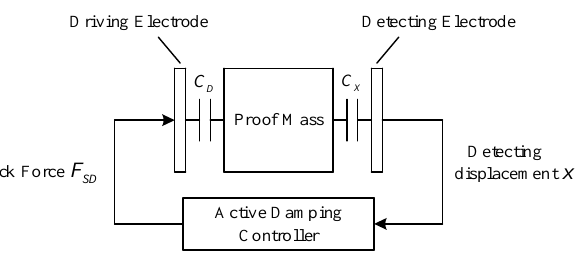
Figure 2. Block diagram of the principle of the electrostatic active damping control.